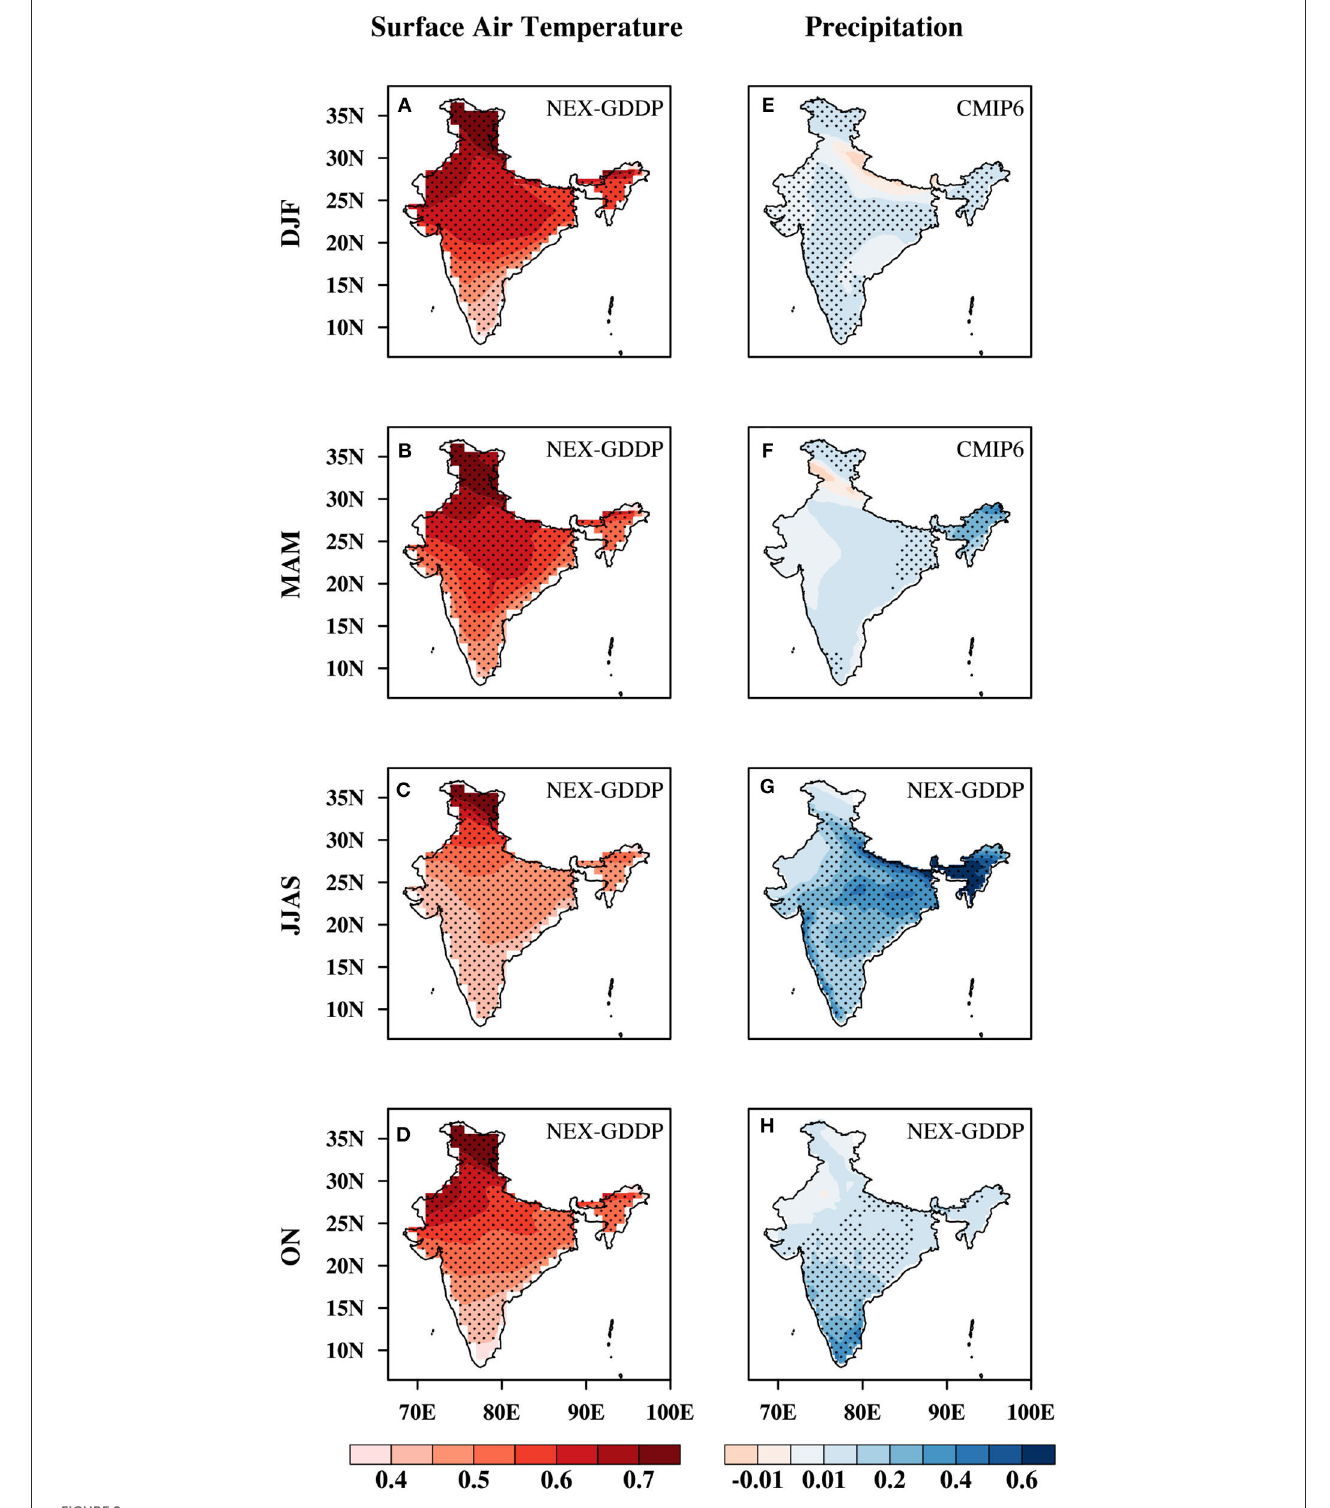
FIGURE2 Spatial pattern of future trends in surface air temperature (A–D) and precipitation (E–H) for the period 2015–2099 for DJF (A, E) , MAM (B, F) , JJAS (C, G) , and ON (D, H) . The text inside the box indicates the MMM used to generate the trends. Stippling shows trends significant at the 99% confidence level. The emission scenarios used for NEX-GDDP and CMIP6 are RCP8.5 and SSP5-8.5,